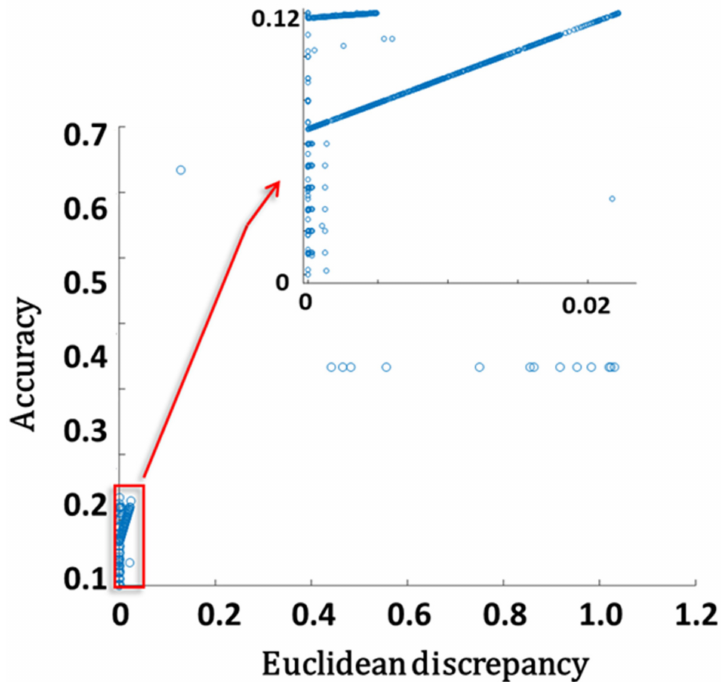
Figure A1. A Pareto frontier computed for a 2.5 kg/s leak from source #5. Different colors mark the feasible solutions obtained at different detector array distances. The graph shows a zoom-in on the Ψ accuracy ≤ 0.01 range of the Pareto frontier.